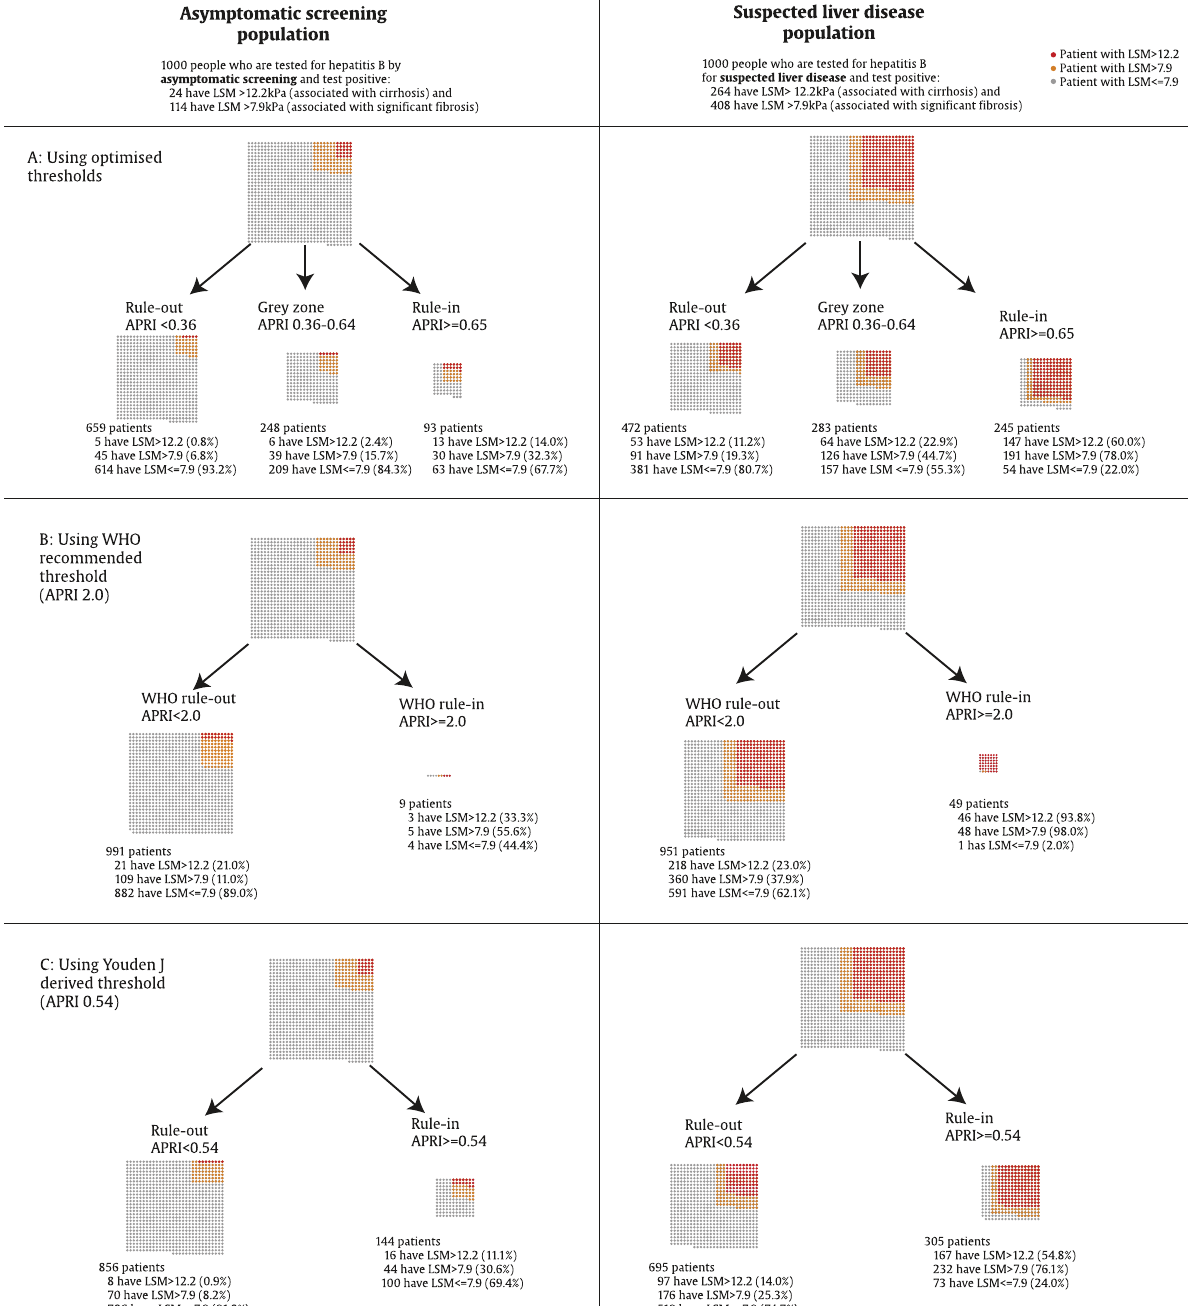
Fig.5|IllustrationofusingAPRItoclassifypatientsinasymptomaticscreening andsuspectedliverdiseasepopulations. Using A rule-inandrule-outthresholds, B the WHO recommended threshold and C Youden J derived threshold a . a A single grey dot represents one person with liver stiffness measurement (LSM)<7.9kPa, one orange dot represents a person with LSM>7.9kPa associated with signi fi cant